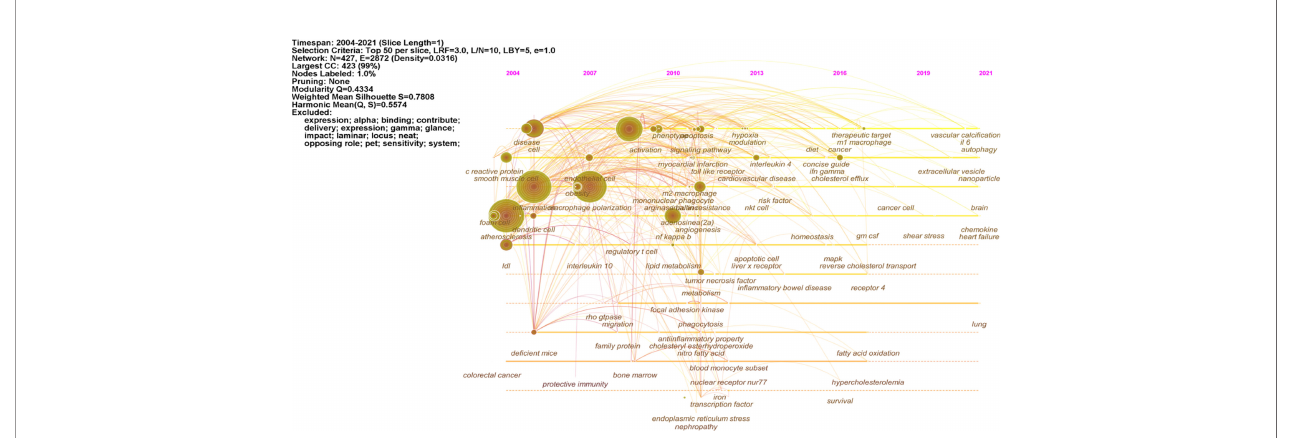
FIGURE 7 | Keyword timeline view of macrophage polarization in AS